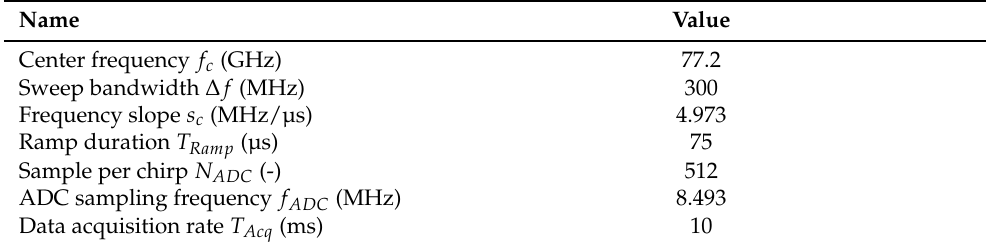
Table 2. Chirp, timing, and analogue/digital conversion (ADC) parameters for the MIMO-SAR